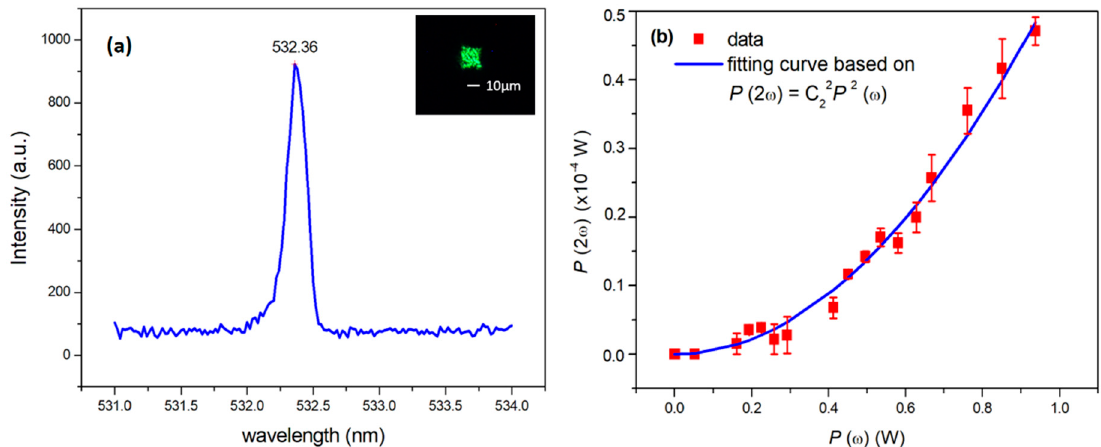
Figure 6. Second-harmonic generation (SHG) measurement of the tetragonal single-crystalline fiber. ( a ) the spectrum of the output SHG signal. The inset is the exit of the tetragonal fiber upon excitation by 1064 nm laser captured by the CCD camera. ( b ) SHG output intensity as a function of the pump power P ( ω ) from a solid-core crystal fiber with D = 18 µ m and L = 1.63 mm. The red triangles are the experimental data, and the red solid line is the fitting curve based on P (2 ω ) = C 22 P 2 ( ω ).